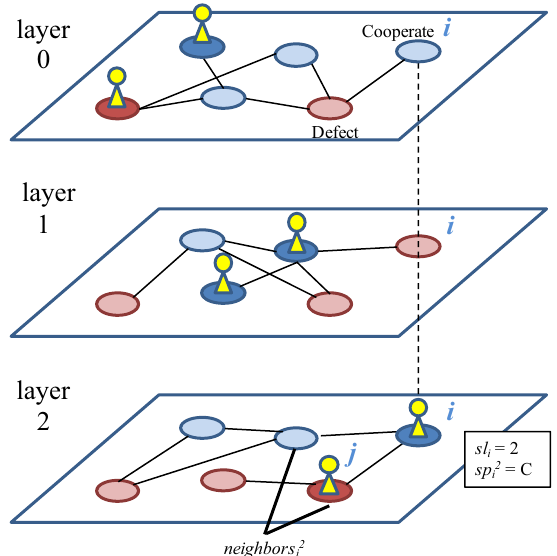
Figure 1. A schematic image of our model ( M = 3). Each individual selects a layer, and plays games with its neighbors in the focal layer who selected the same layer. In other words, a game is played between neighboring individuals in the same